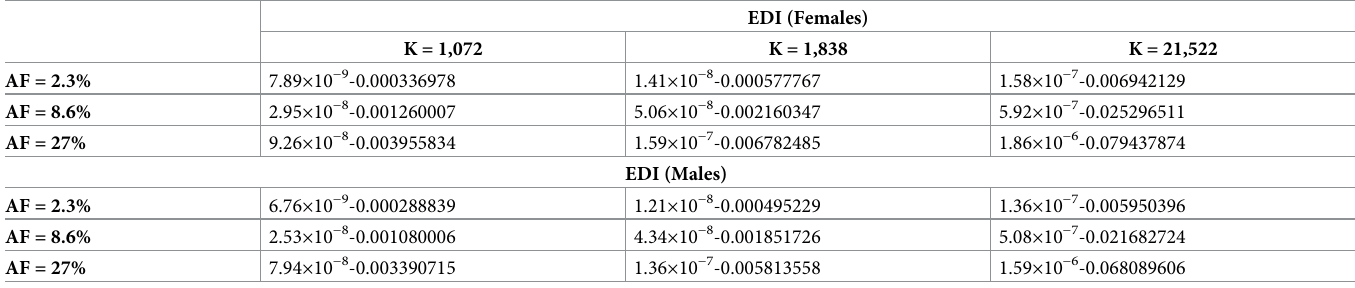
Table 7. EDI ( μ g/kg bw/day) range for cashier (females and males) from “supermarket” thermal paper receipts under varying AF and k